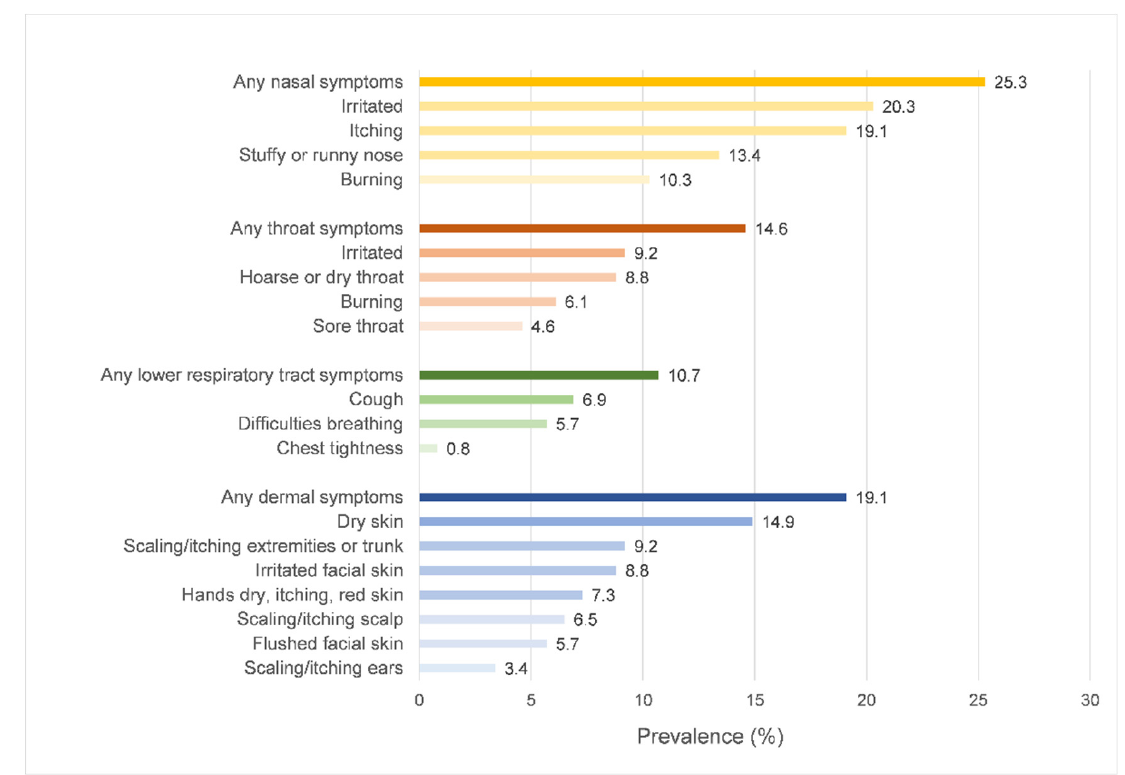
Figure 2. Prevalence of SBS